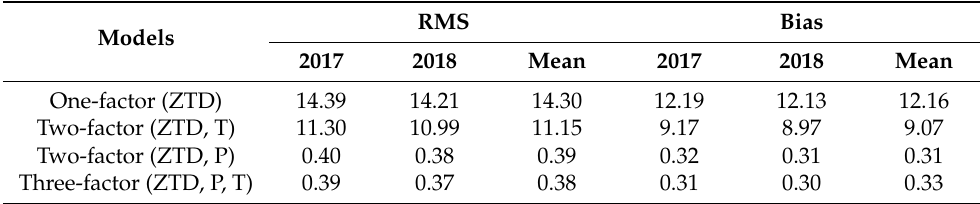
Table 4. Precision statistics of the one-, two-, and three-factor PWV conversion models (mm). RMS Models